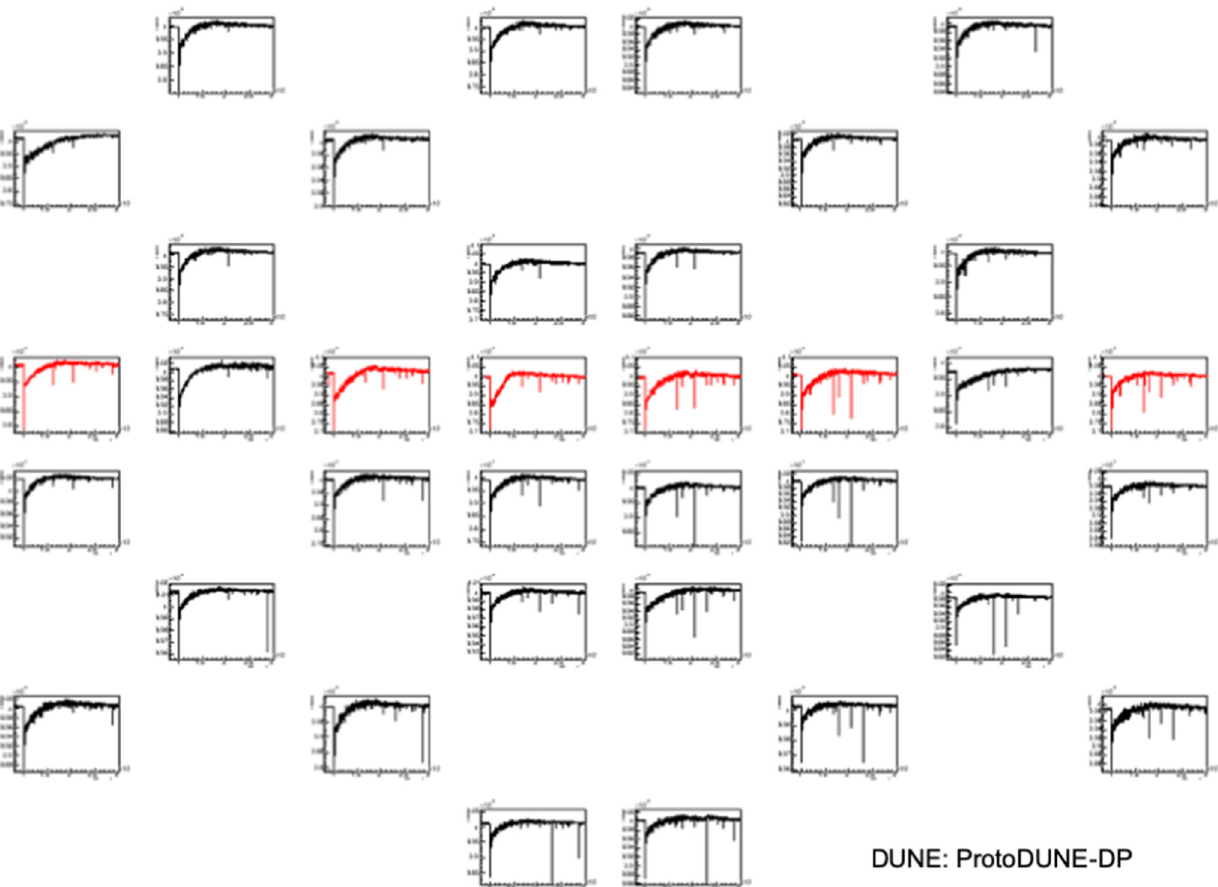
Fig. 23 ExampleofaneventwithS1andS2signalsshowingthewave- forms corresponding to the 36 PMTs according to their relative position in the detector. PEN PMTs are shown in black and TPB PMTs in red.